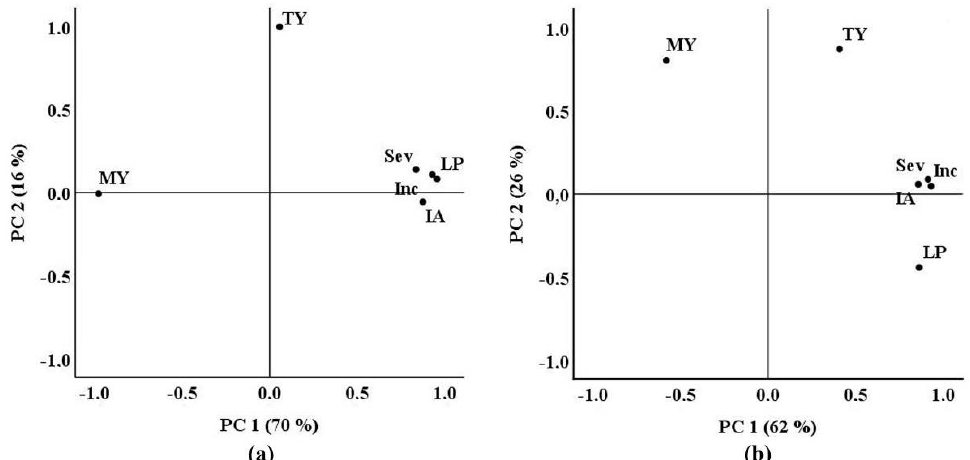
Figure 4. Principal component analysis of the potato common scab control as a function of treatments in the ( a ) first and ( b ) second experiment. MY = marketable yield, TY = total yield, Sev = severity, IA = injured area, Inc = incidence, LP = loss of production.